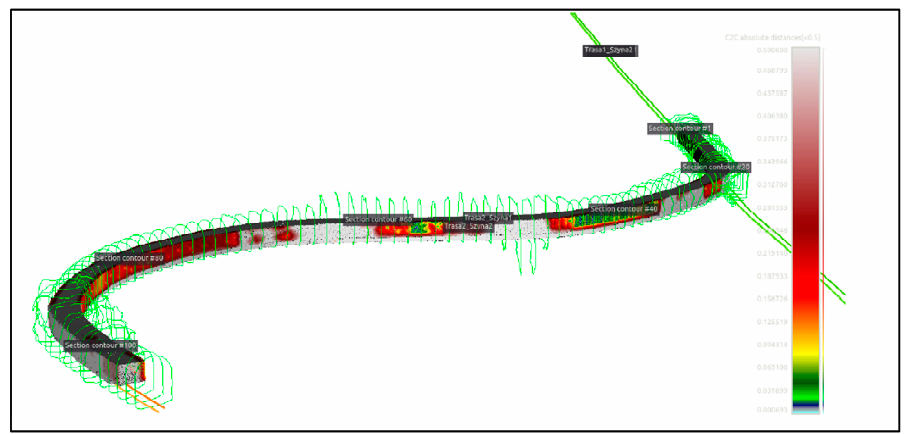
Figure 5. An example of ‘Cloud-to-Cloud Distance computation’.